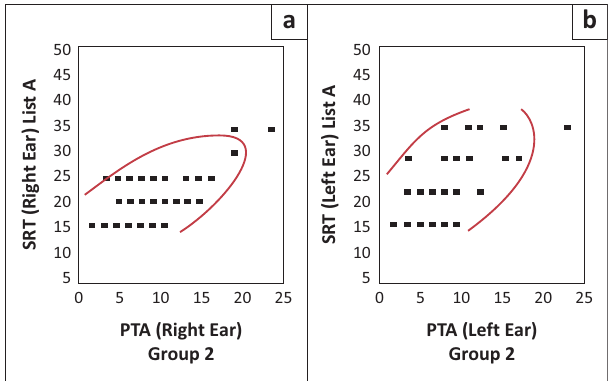
FIGURE 2: Pure-tone average/speech recognition threshold correlation for list A in group two ( N = 46R; 46L)